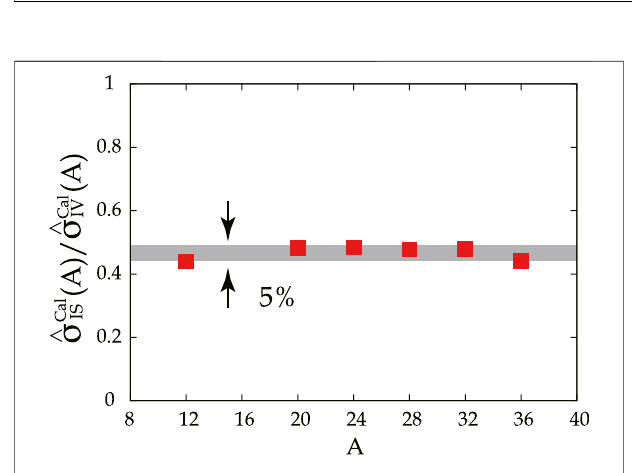
FIGURE 6 | Mass dependence of ratio of IS to IV UCSs studied by